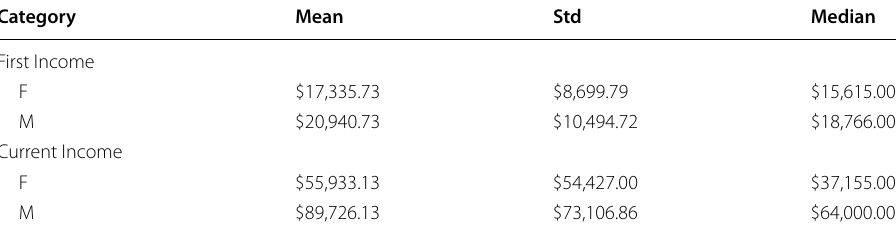
Table 2 First Income and Current Income median, mean, and standard deviation statistics by Gender Category